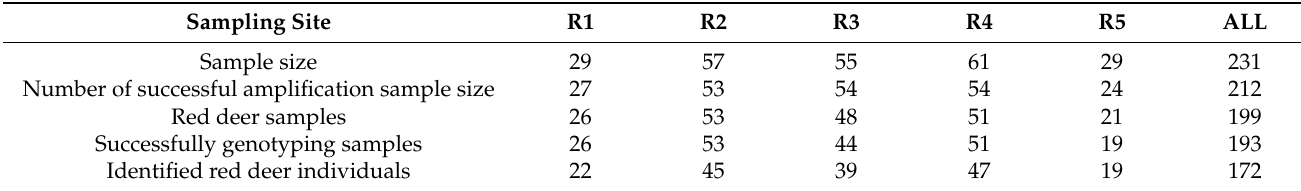
Table 3. The amplification information for eight microsatellite